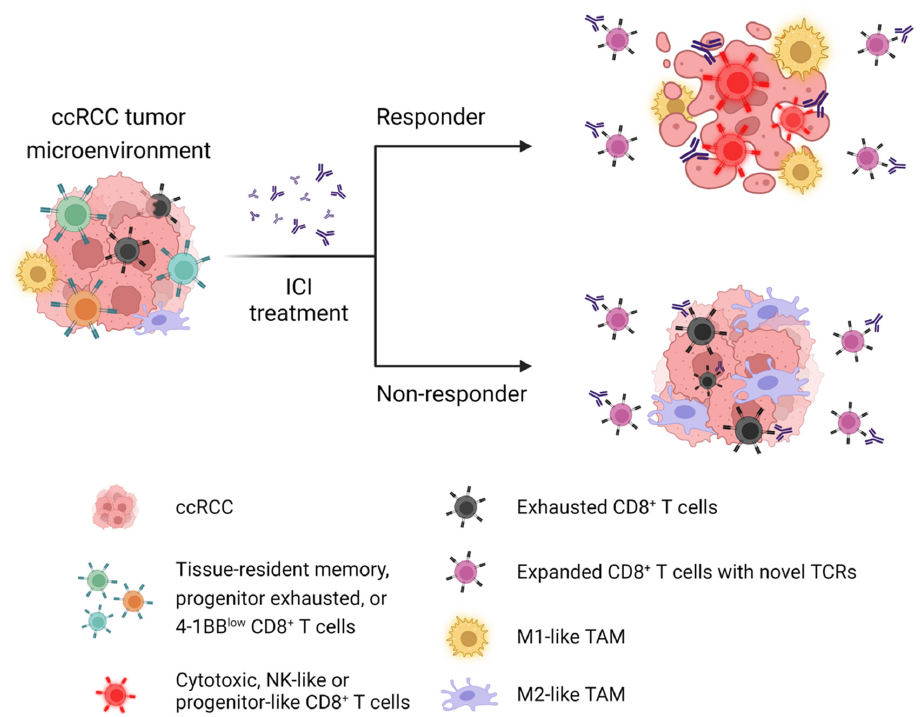
Figure 3. Current concept of immunotherapy driving clinical response to ICI in patients with ccRCC. Pre-existing CD8 + T cell clones phenotyped by CD69+ZNF683+ TRM, progenitor exhausted, or 4-1BB low are considered to have a critical role in